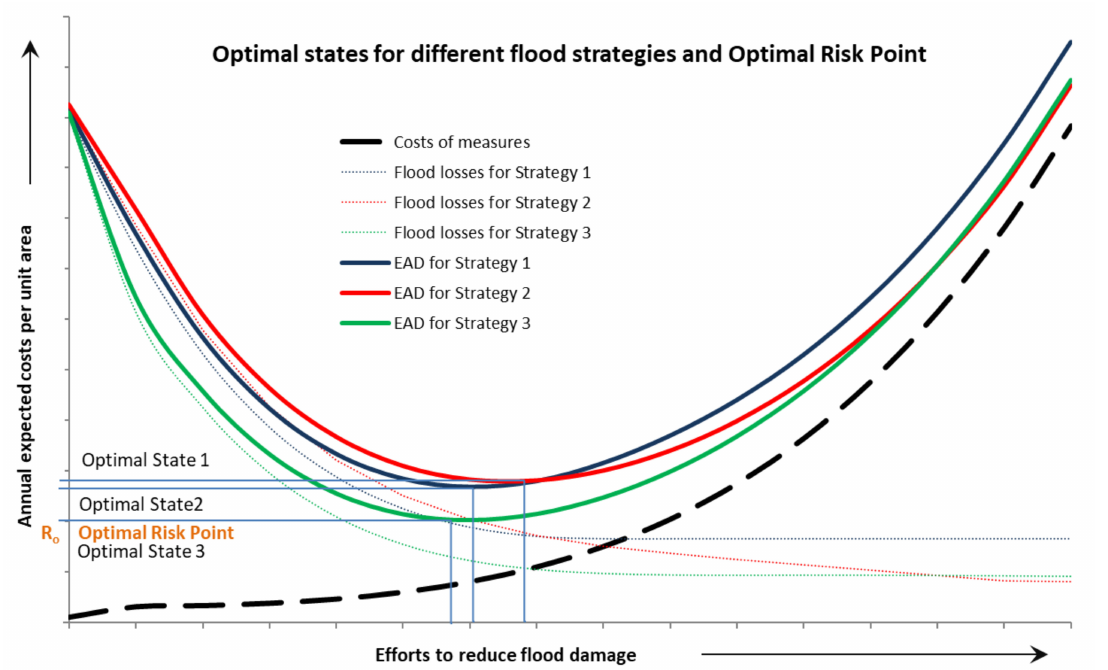
Figure 4. An illustration of three examples of land use and the establishment of the optimal risk point (ORP) in a floodplain using comparative risk analysis of di ff erent